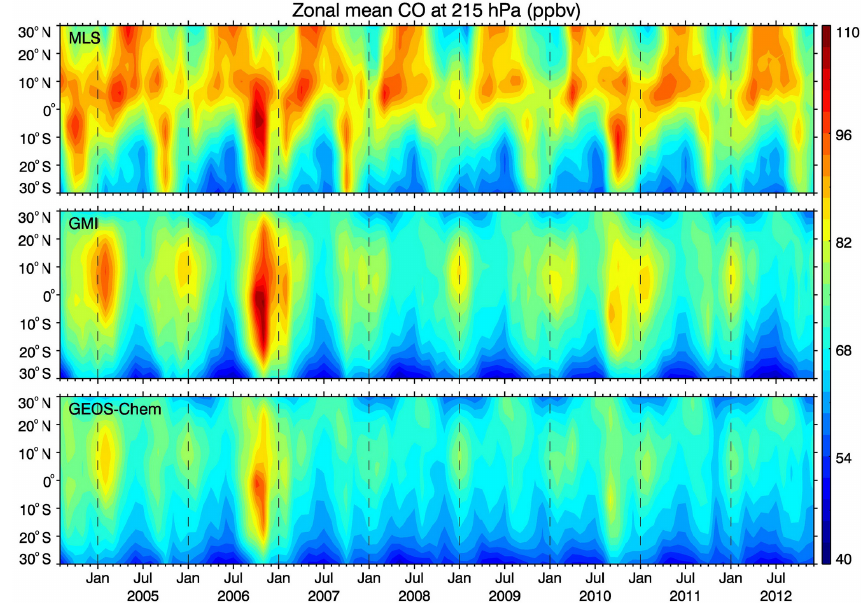
Figure 5. Monthly variation of zonal mean CO mixing ratio at 215hPa for August 2004–December 2012 from (top row) MLS V4 data; (middle row) GMI model simulation with MLS AKs applied; (bottom row) GEOS-Chem model simulation with MLS AKs